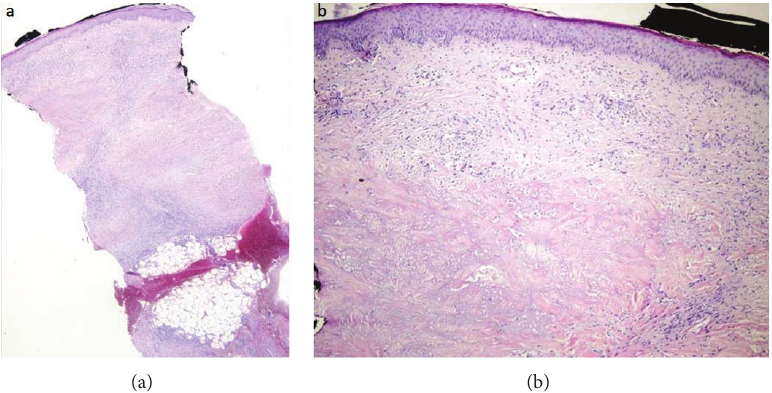
Figure 2: (a) The loss of epidermis rete with degenerative collagenous plaques in the dermis and peripheral histiocytic palisades (H&E × 10). (b) Subcutaneous multiple granuloma with plasma cells, lymphocytes, and multinuclear giant cells (H&E × 20).